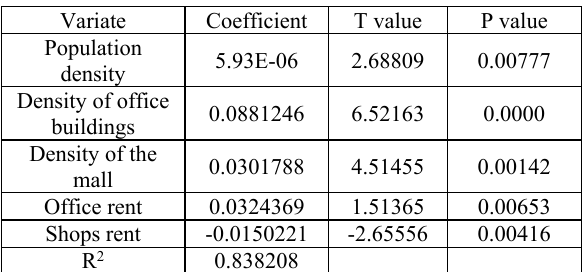
Table 6 . OLS regression results of the density of Luckin Coffee stores in